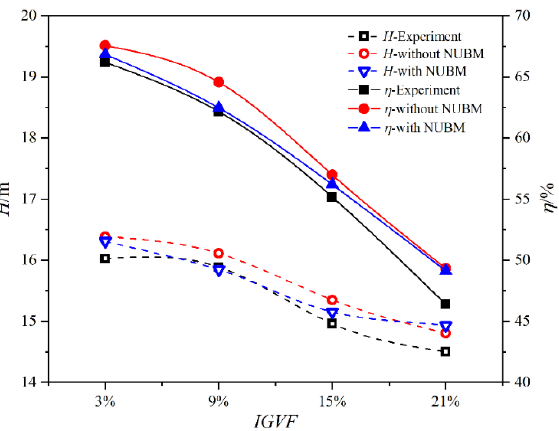
Figure 4. Comparison between experimental measurement and numerical simulation.